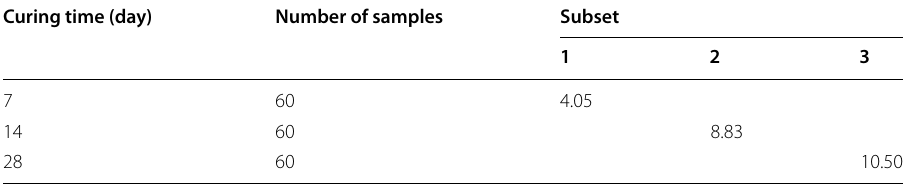
Table 9 Effect of curing time on mean compressive strength of all the samples Curing time